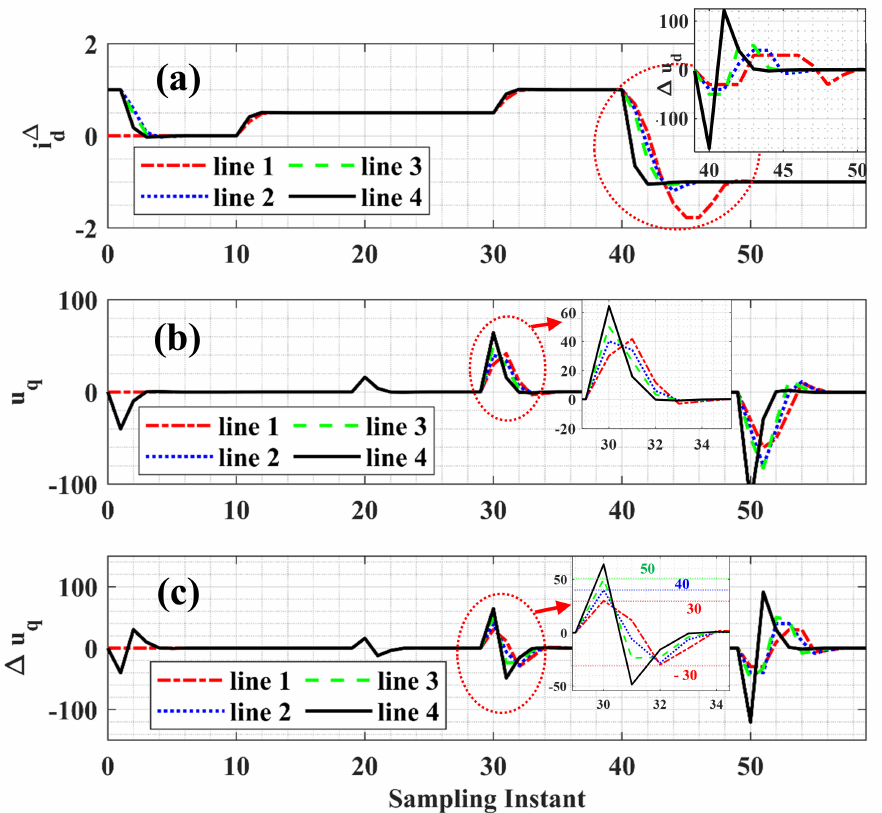
Figure 14. Case- studies with rate constraint, line 1: | ∆ u d | = | ∆ u q | = 30, line 2 : | ∆ u d | = | ∆ u q | = 40, line 3 : | ∆ u d | = | ∆ u q | = 50, and line 4: